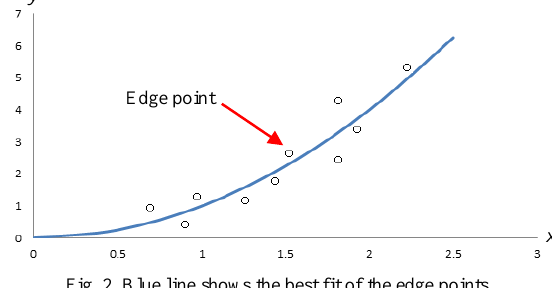
Fig. 2. Blue line shows the best fit of the edge points.